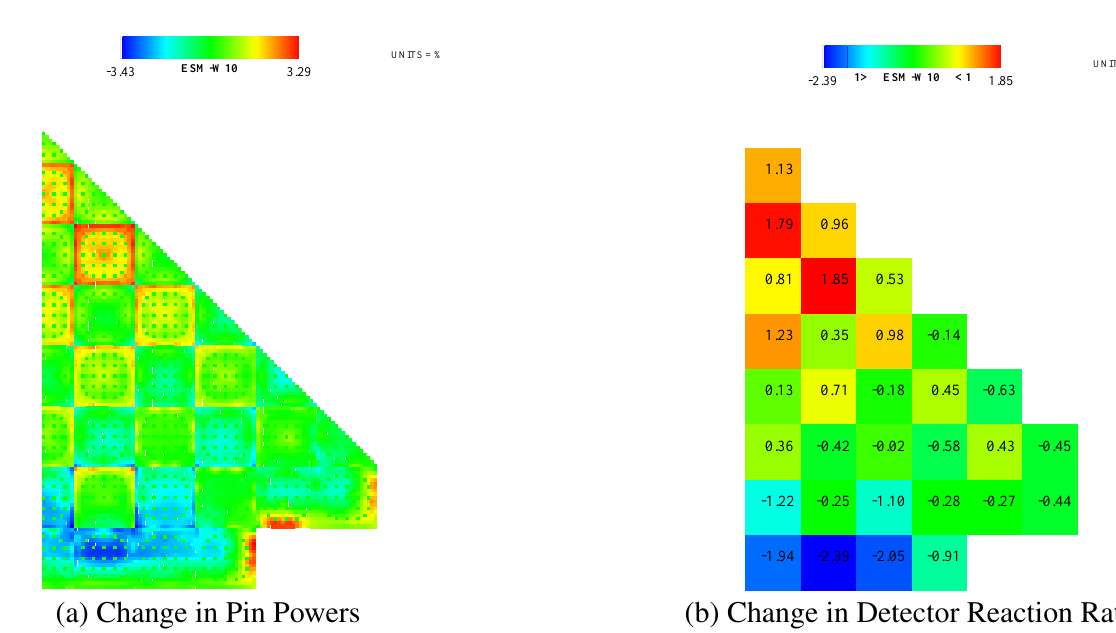
Figure 1: Example Pin Power and Detector Changes Introduced by the